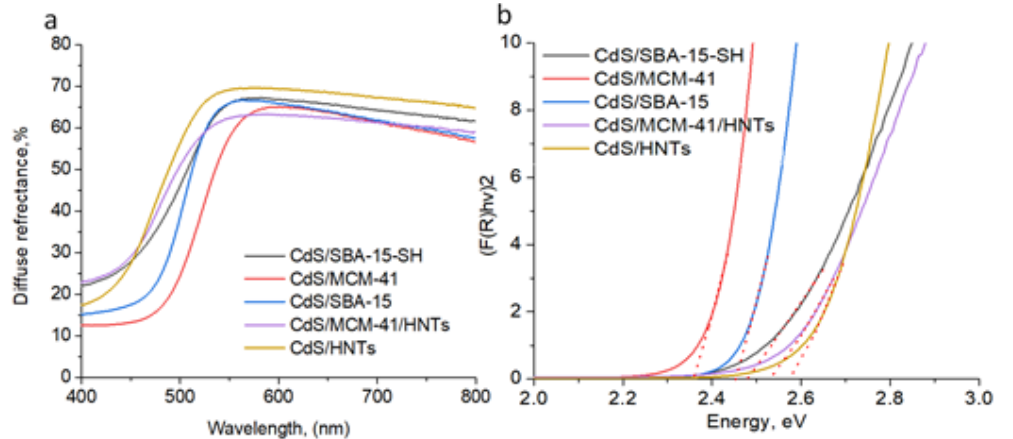
Figure 5. Diffuse reflectance spectra ( a ) and correspondent Tauc plot ( b ) of CdS-based mesoporous materials.